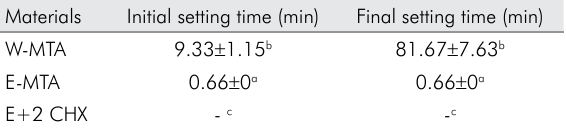
Table 4. Initial and final setting time (mean ± standard deviation, n = 3 for each material) determined by Gillmore needles at 37 o C and 98% relative humidity. E-MTA was light-cured for 40